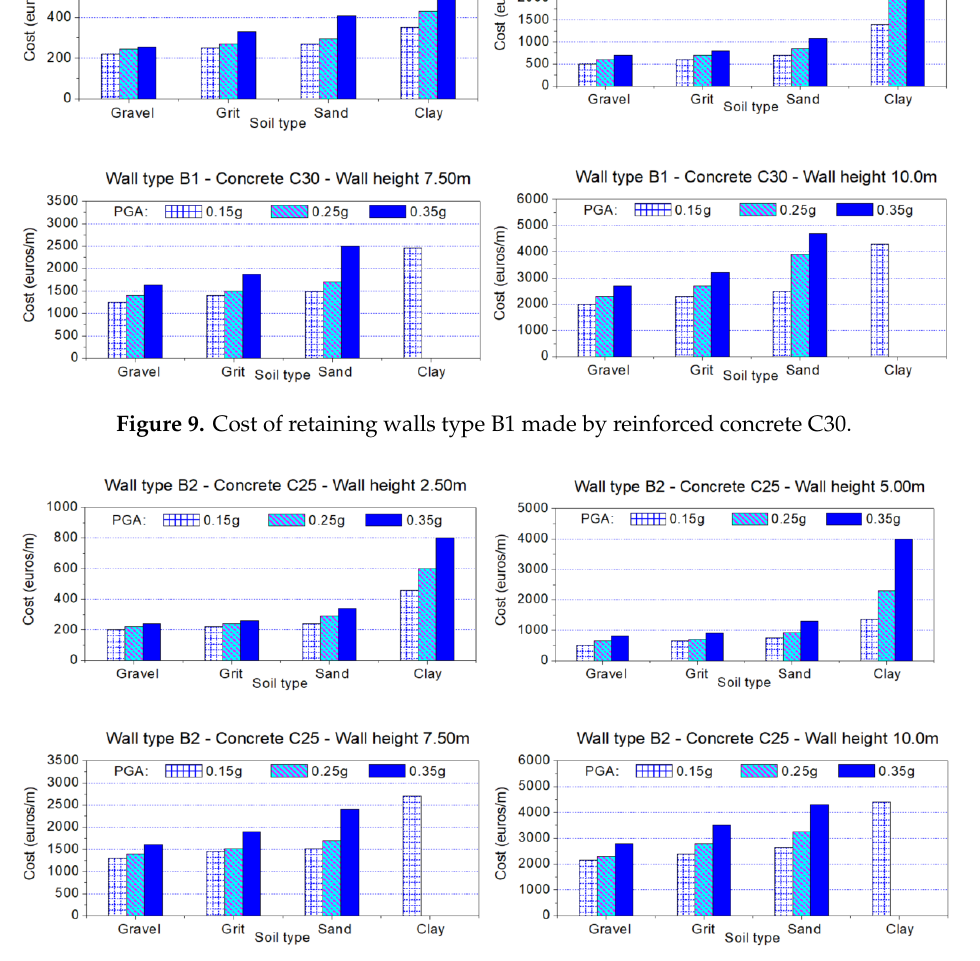
Figure 11. Cost of retaining walls type B2 made by reinforced concrete C25. Figure 10. Cost of retaining walls type B2 made by reinforced concrete C25. Figure 10. Cost of retaining walls type B2 made by reinforced concrete C25. Figure 10. Cost of retaining walls type B2 made by reinforced concrete C25.